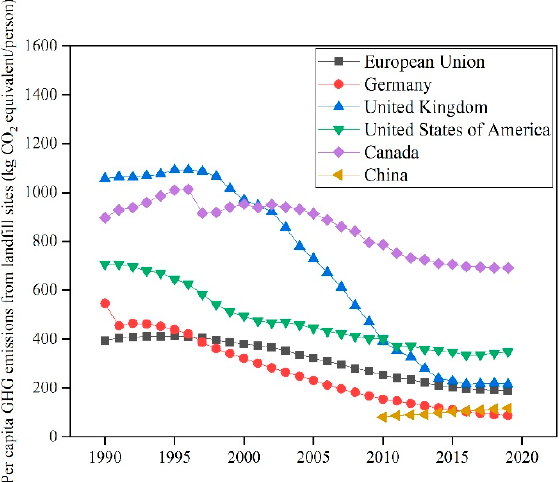
Figure 4. Per capita GHG emissions from landfill sites.